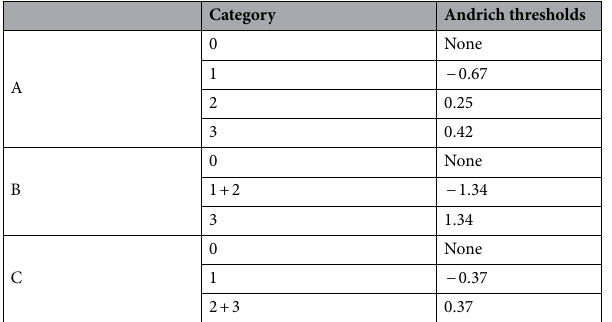
Table 1. Andrich thresholds values (logits) for the 33-item pilot version of SQVD with its original four categories and collapsing categories. A: results for 33-item pilot version with the initial four categories of